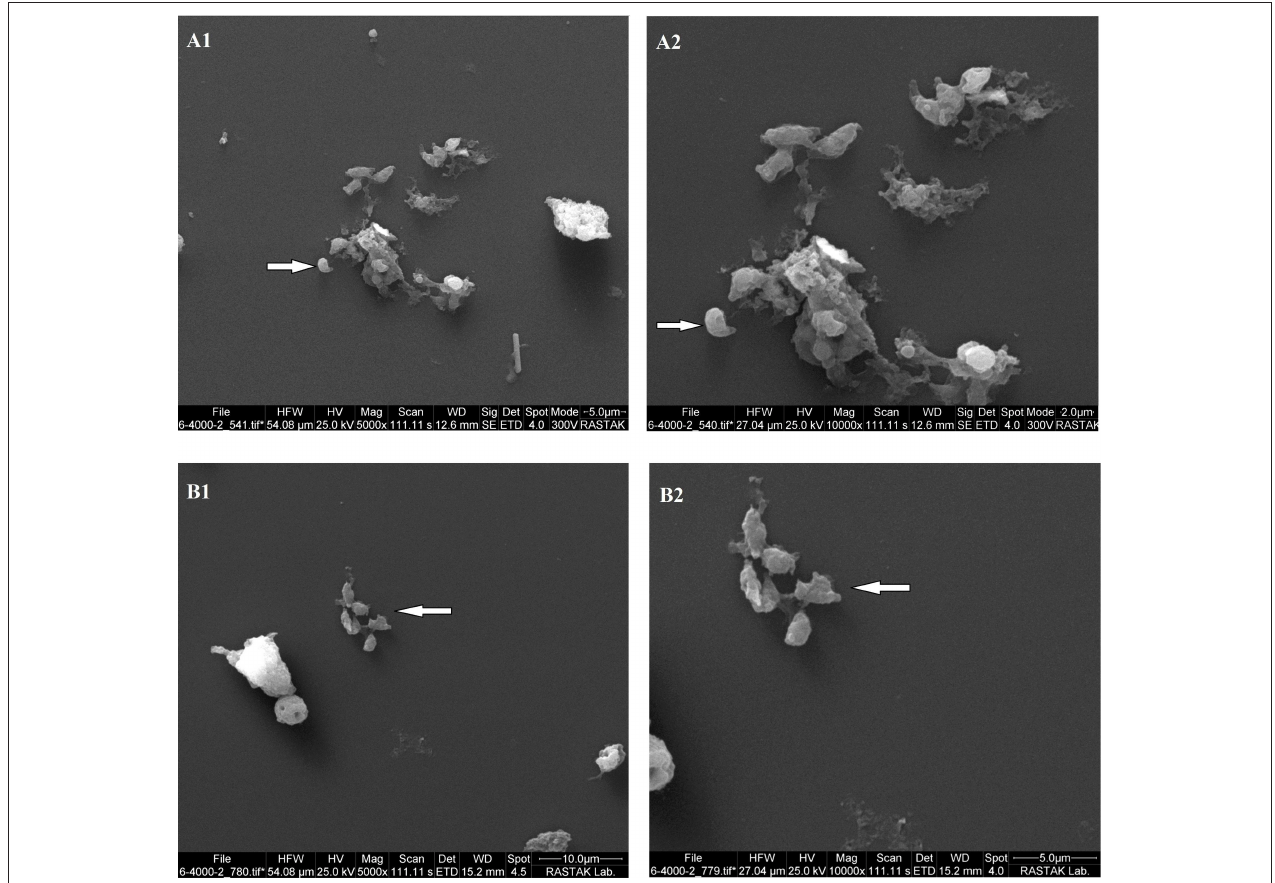
FIGURE 7 | The results of SEM analysis reveals changes in size and morphology of Toxoplasma tachyzoites in two magnifications. (A1,A2) show untreated tachyzoites, and (B1,B2) show PM-SLN-M treated